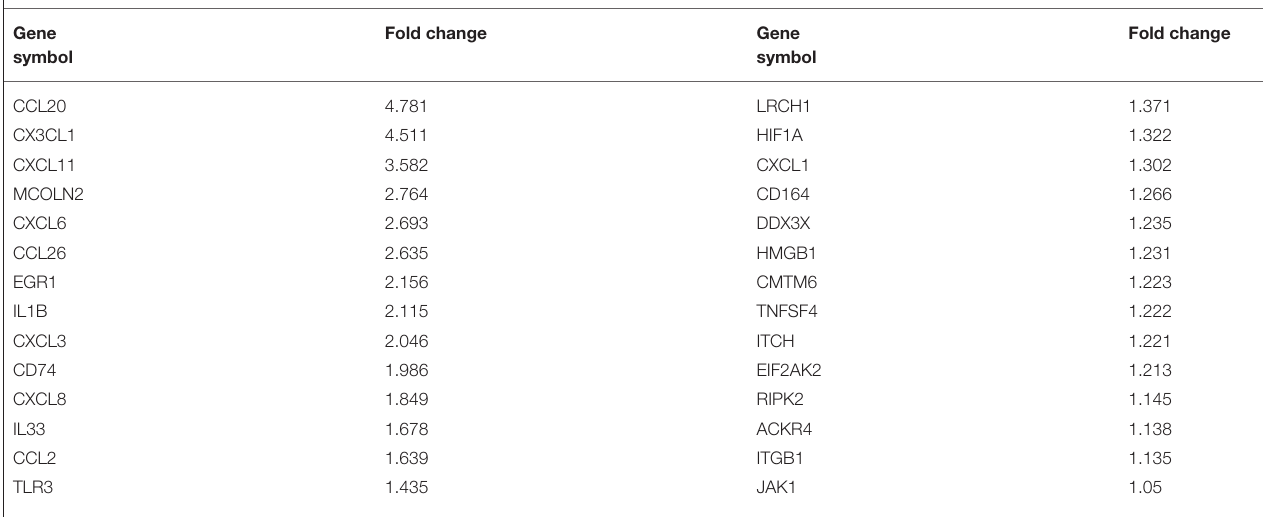
FIGURE 5 | Cytokines and chemokines showed significant upregulation in LPI-treated HAECs compared with the control HAECs. (A) One hundred seventy-nine cytokines were significantly upregulated in LPI-treated HAECs. (B) Twenty-eight chemokines were significantly upregulated in LPI-treated HAECs.